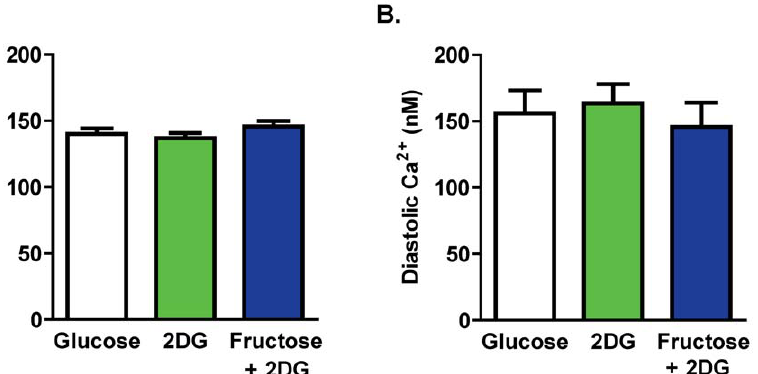
Figure 2. Baseline twitch and Ca 2 + transient parameters. A. Diastolic cell length. B. Diastolic Ca 2 + levels. Data presented as mean 6 s.e.m. n=10–28